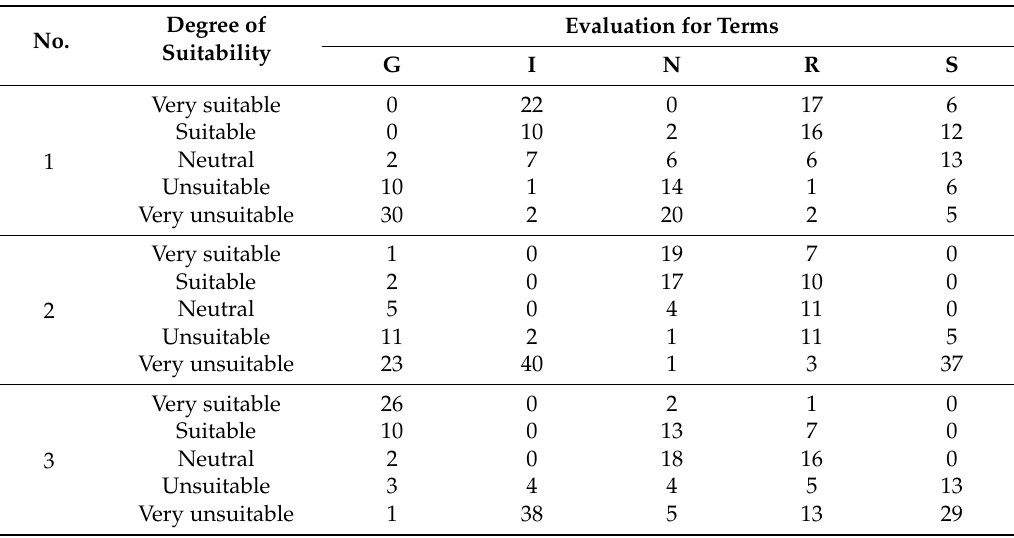
Table 6. Evaluation of suitability of the five